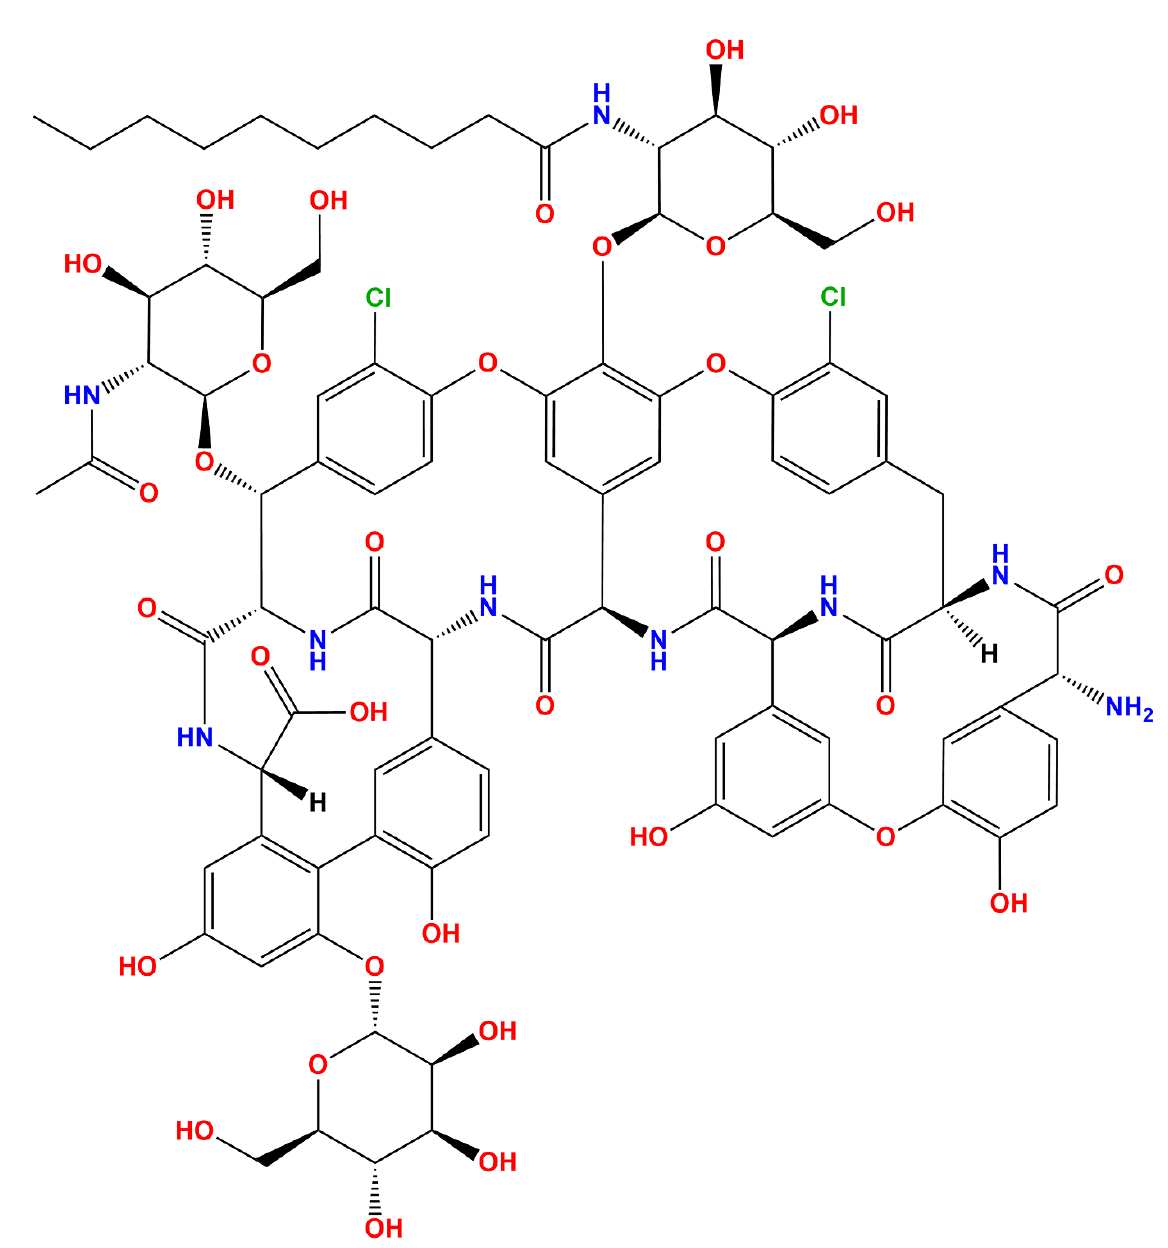
Figure 1. Two-dimensional structural coordinate of teicoplanin (ACD/ChemSketch program version 2020.2.1, of Advanced Chemistry Development, Inc., Toronto, ON, Canada, was used for drawing the chemical structure).